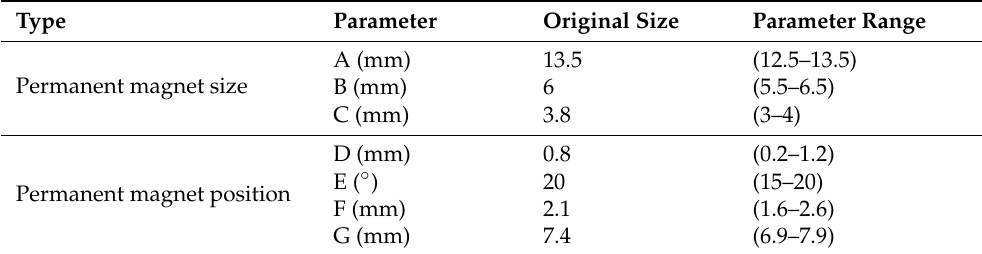
Table 7. Range of single variable test variables.